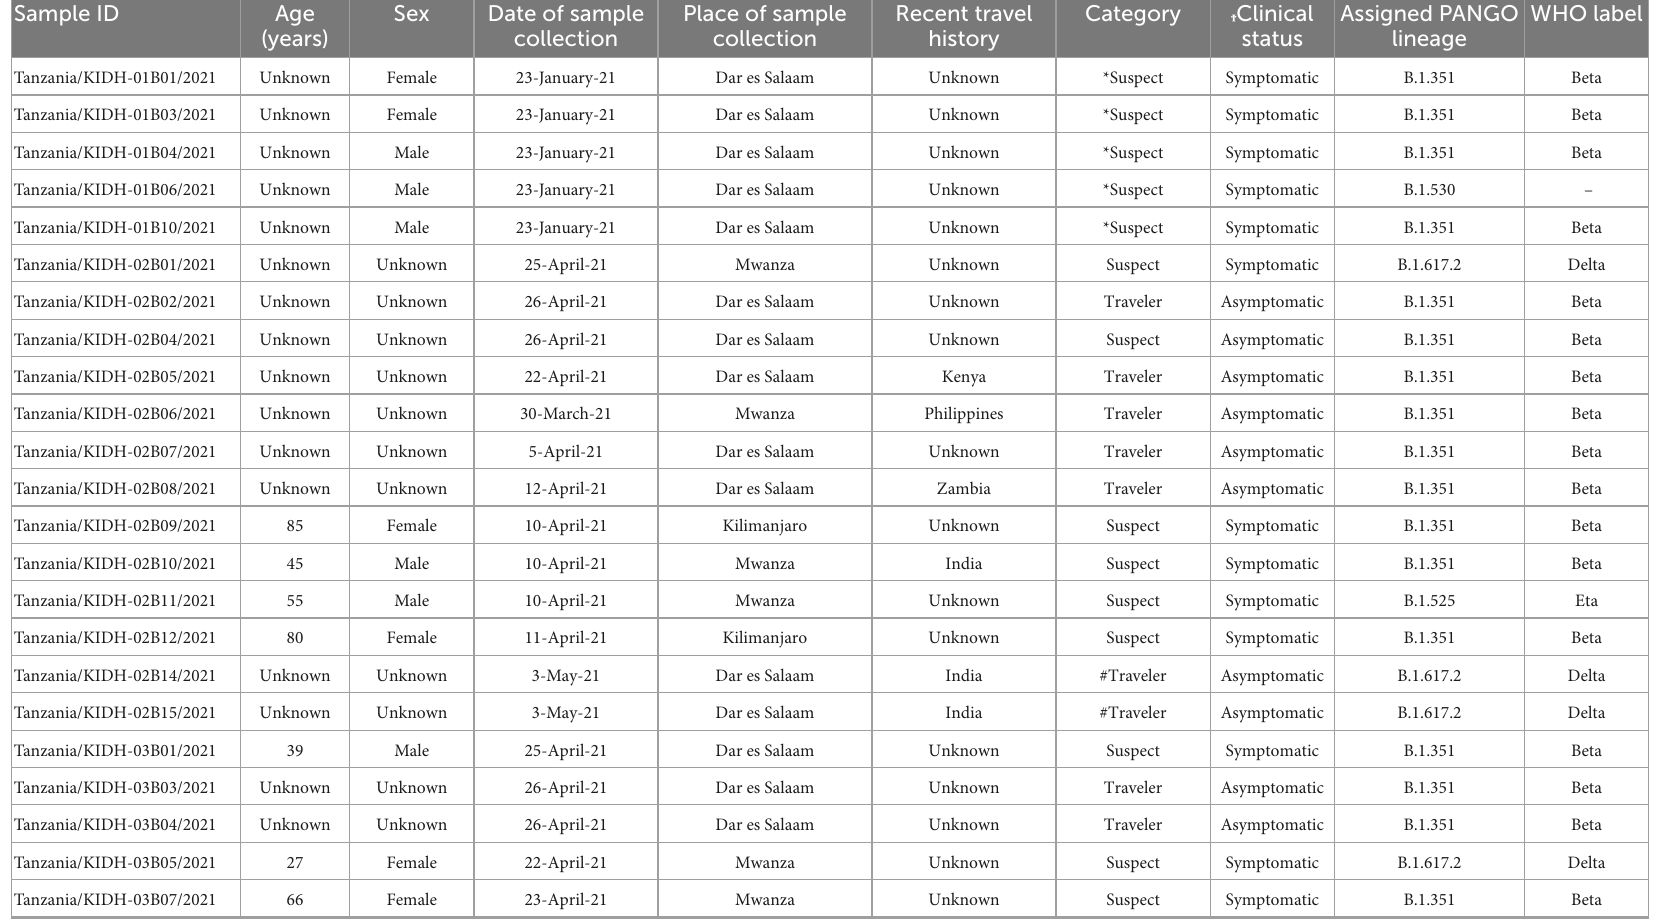
TABLE 2 Characteristics of sequenced samples ( n =